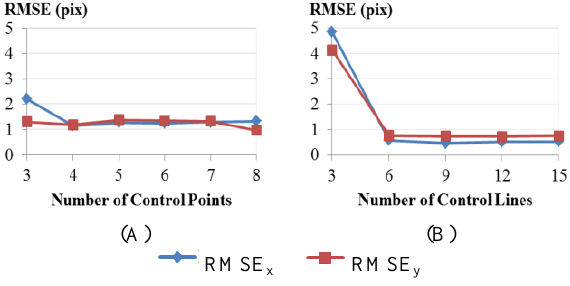
Figure 7. Error statistics: (A) point control (B) line control